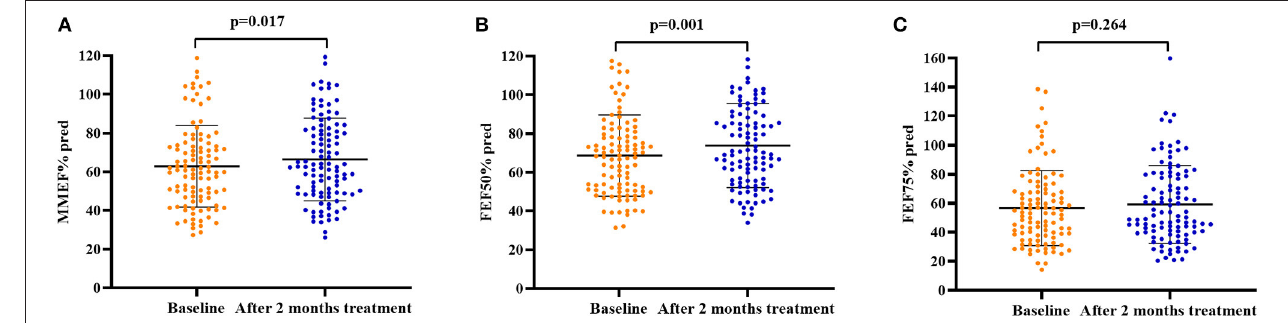
FIGURE 2 | Spirometry parameters of small airway function at baseline and after 2 months of antiasthmatic treatment in 105 patients with CVA. (A) MMEF% pred at baseline and after 2 months of antiasthmatic treatment; (B) FEF50% pred at baseline and after 2 months of antiasthmatic treatment; (C) FEF75% pred at baseline and after 2 months of antiasthmatic treatment. Bars indicate the mean ± SD. MMEF, maximal mid-expiratory flow; FEF50%, forced expiratory flow at 50% of forced vital capacity; FEF75%, forced expiratory flow at 75% of forced vital capacity; SAD, small airway dysfunction.